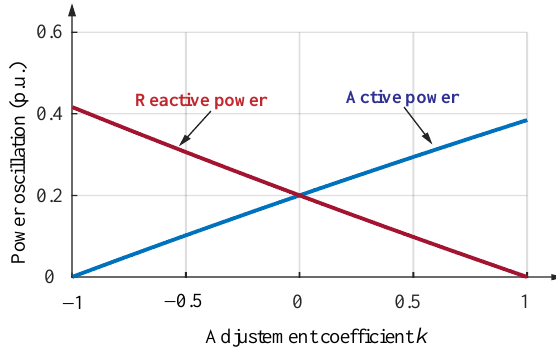
Figure 2. Oscillation value of output power varying with the adjustment coefficient. The variation of k represents different control strategies. The power oscillation cannot be eliminated by just changing the control strategy when the topology is not optimized.